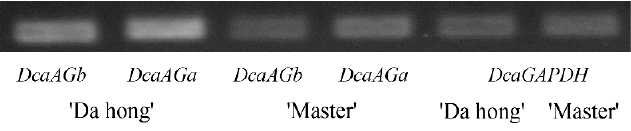
Figure 4. Semi-quantitative PCR (sq-PCR) analysis of two DcaAG genes in single and double flower phenotype carnations. The expression of both DcaAG genes in the double flower phenotype carnation were lower than that in the single flower phenotype carnation.